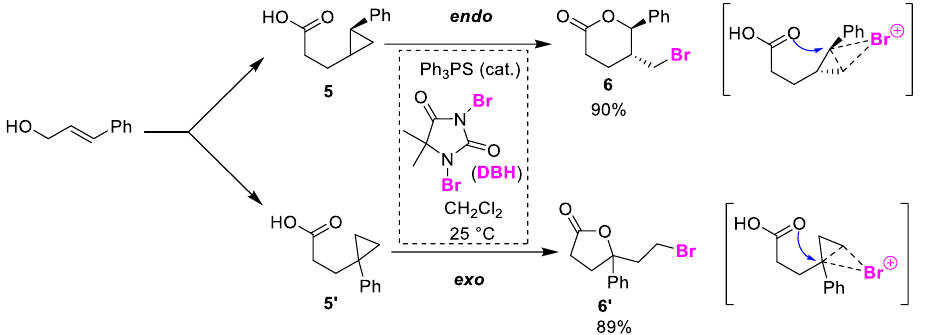
Figure 4. Regioisomer-dependent endo / exo -selective bromolactonizations of cyclopropyl carboxylic acids 5 and 5′ .